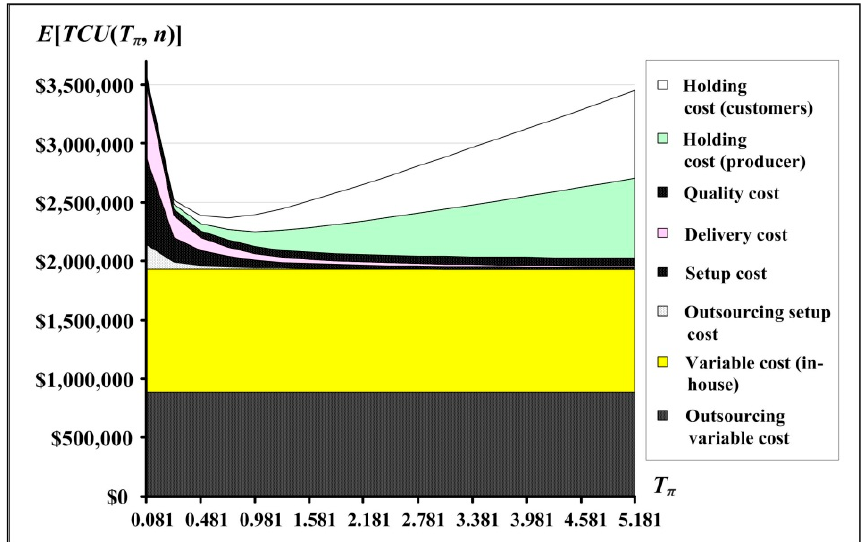
Figure 8. Effect of variations in T π on different cost contributors of E [ TCU ( T π , n )]. Figure 8. E ff ect of variations in T π on di ff erent cost contributors of E [ TCU ( T π , n )].